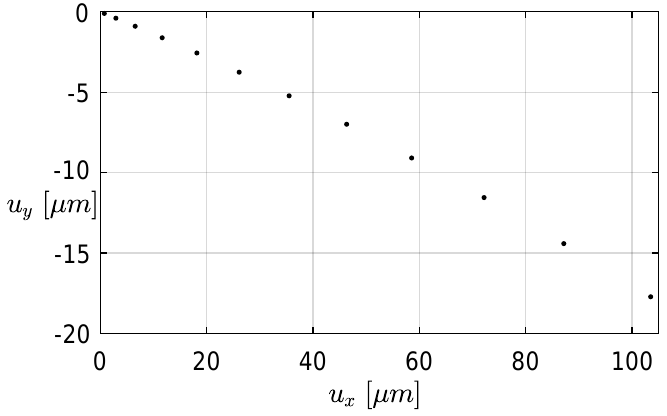
Figure 8. Tip path followed by the one-link microgripper along the x - and y -axes (see Figure